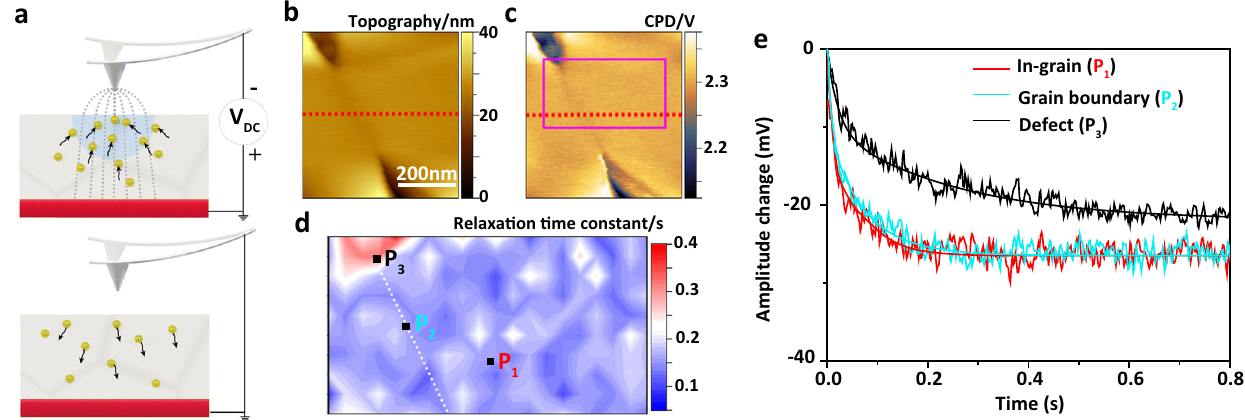
Fig. 3 | Tr-EFM measurement on LLZO surface. a Schematic illustration of the principle of tr-EFM on LLZO. b SFM topography of LLZO including voids, grain boundaries, and in-grain parts. The RMS roughness is 4.1nm at 500nm×500nm. c CPDmapofthesameplaceasin b . d Lithiumionrelaxationtimeconstant( τ )map